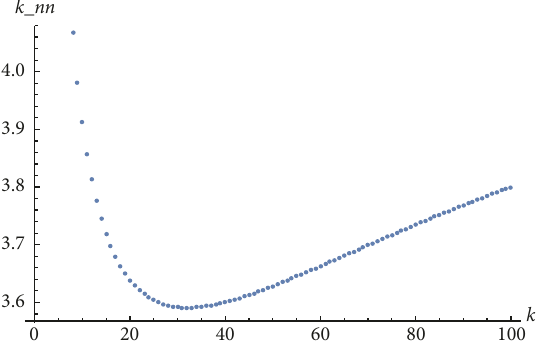
Figure 6: Function 𝑘 𝑛𝑛 for a BA network with 𝛽 = 1 , 𝑛 = 100 (largest degree; the corresponding number of nodes is 𝑁 ≃ 10 4 ).